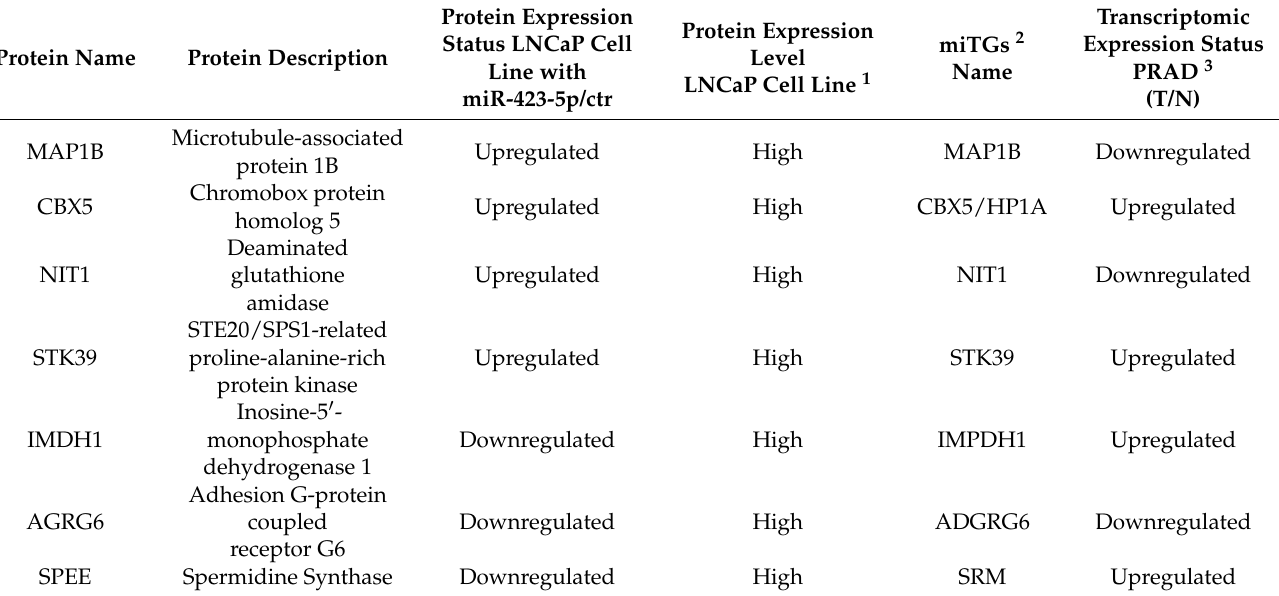
Table 7. Expression status of miR-423-5p target proteins from mass spectrometry analysis, protein expression level in LNCaP cell line from Atlas, and miTGs expression pattern of prostate adenocarci- noma (PRAD) dataset obtained using